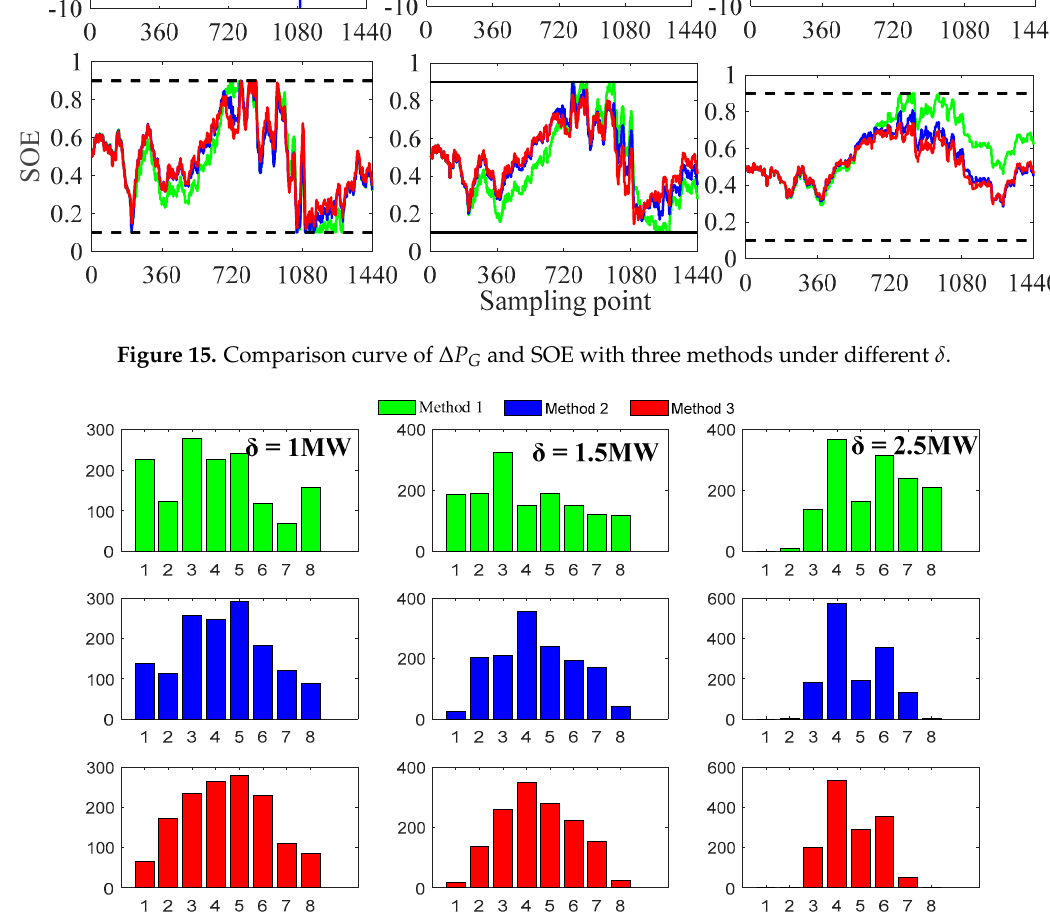
Figure 16. Frequency distribution histogram of different energy storage SOE intervals under different δ during a typical day. Table 6. Assessment criteria under different Q Table 7. Assessment criteria under different δ .